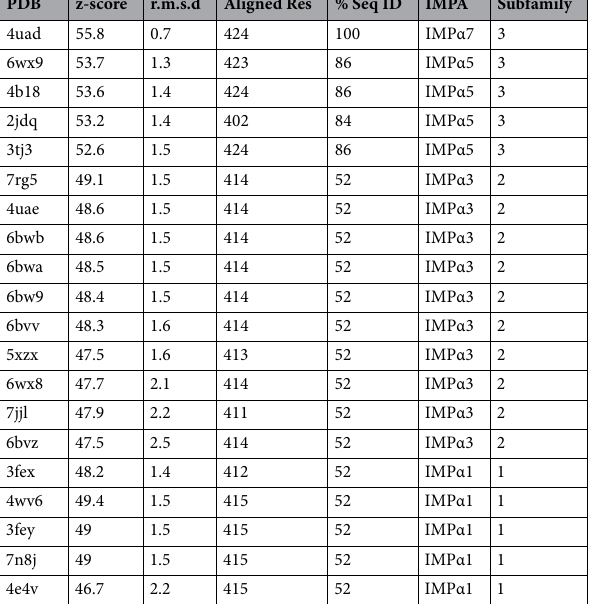
Table 2. Structural comparison of IMPα7 structure with other human IMPα